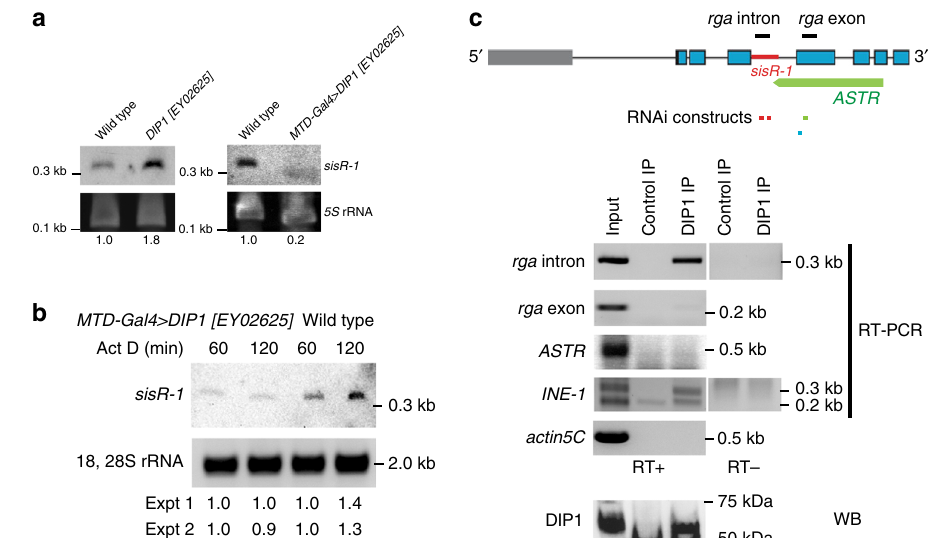
Fig. 1 DIP1 regulates sisR-1 . a Representative northern blots (out of at least three biological replicates) showing the expression of sisR-1 in the ovaries of the indicated genotypes. 5S rRNA was used as a loading control. Numbers below indicate relative band intensities of sisR-1 normalized to rRNA quanti fi ed using ImageJ software. b Northern blot showing the levels of sisR-1 in the ovaries of the indicated genotypes after 60 and 120 min of actinomycin D treatment. 18, 28S rRNA was used as a loading control. Numbers below indicate relative band intensities (120 min compared to 60 min) of sisR-1 normalized to rRNA quanti fi ed using ImageJ software from two independent experiments. c RT-PCR and western blot showing enrichment of sisR-1 and INE-1 but not rga exonic sequences and ASTR in DIP1 immunoprecipitated samples. Actin5C was used as a negative control for unspeci fi c pull down. The regions where the intronic and exonic sequences were ampli fi ed by PCR were shown on the rga gene model. The red line in the intron is where sisR-1 is encoded. Locations of RNAi constructs used to target sisR-1 ( red ), ASTR ( green ), and rga ( blue ) were indicated. WB, western